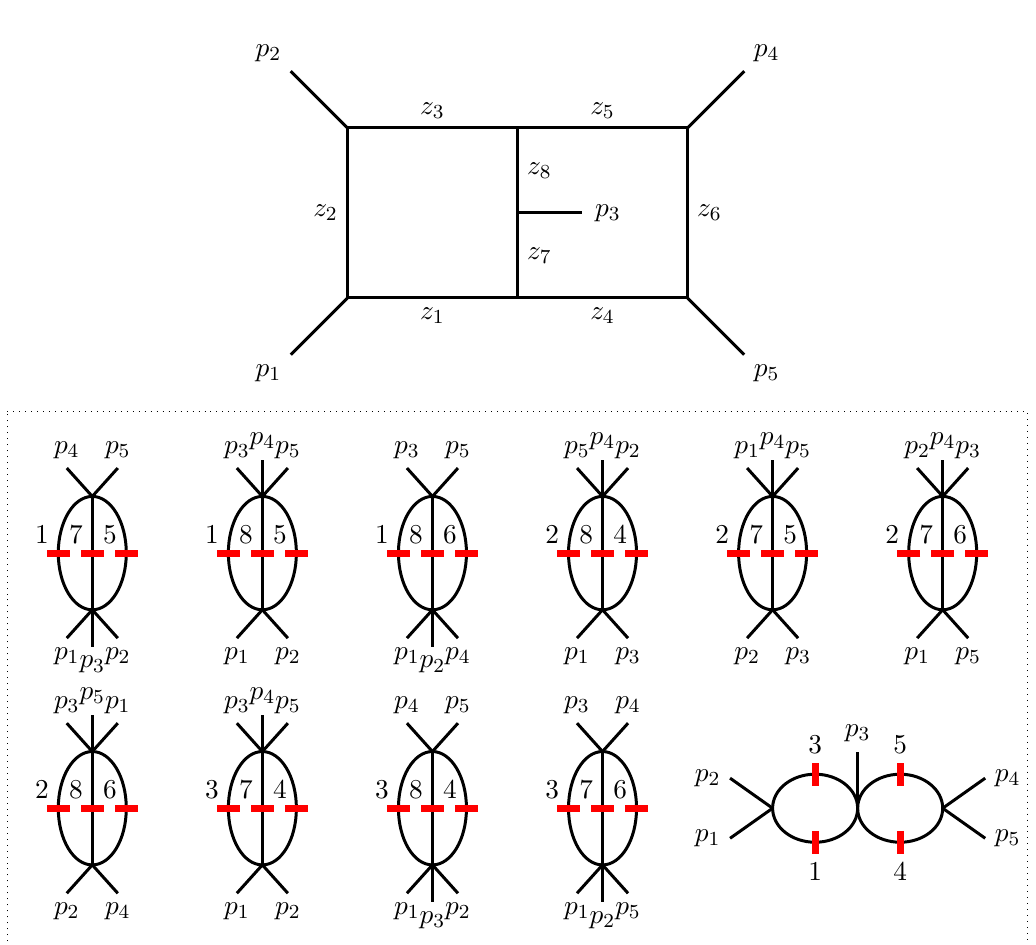
and z 4 = l 2 . 1 2